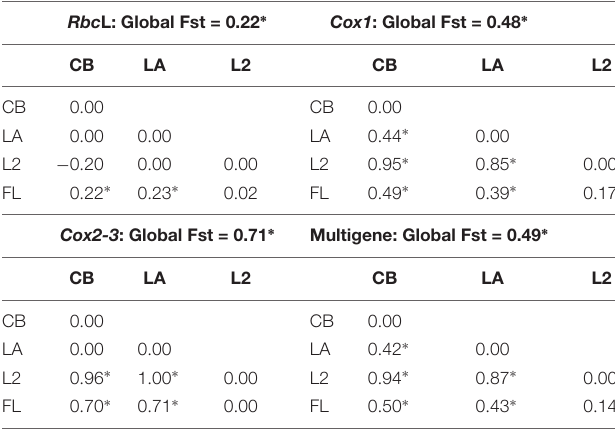
TABLE 3 | Haplotypes of Botryocladia occidentalis and their regional distribution in the Gulf of Mexico. Gene Haplotype Distribution